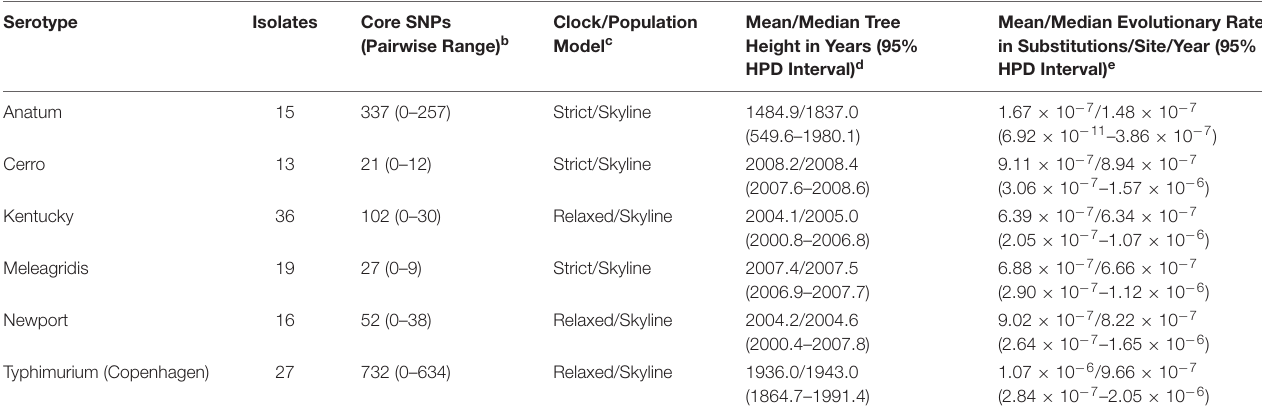
TABLE 3 | Summary of within-serotype evolutionary analyses a .